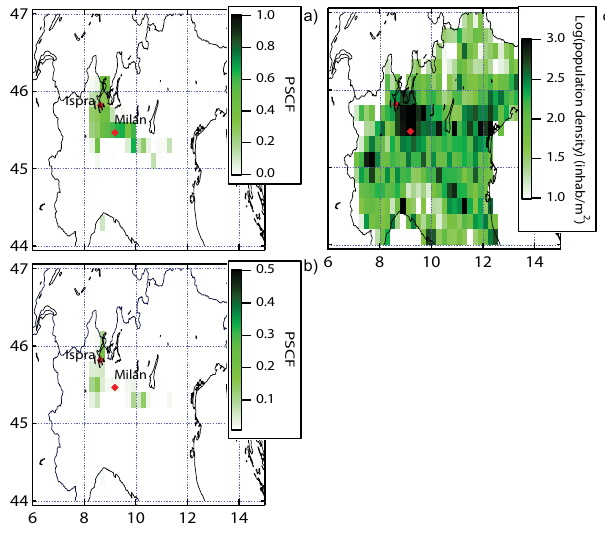
Fig. 6. PSCF maps of fossil fuel combustion (panel a ) and biomass burning (panel b ) aerosol; panel (c) shows northern Italy population density (ISTAT